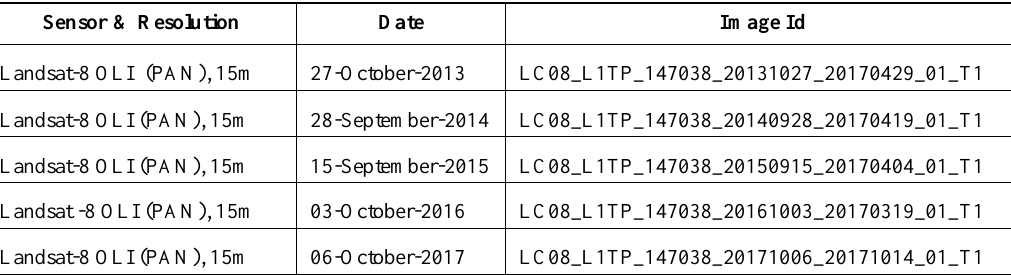
Table 1. Landsat-8 OLI (PAN) images used to estimate surface